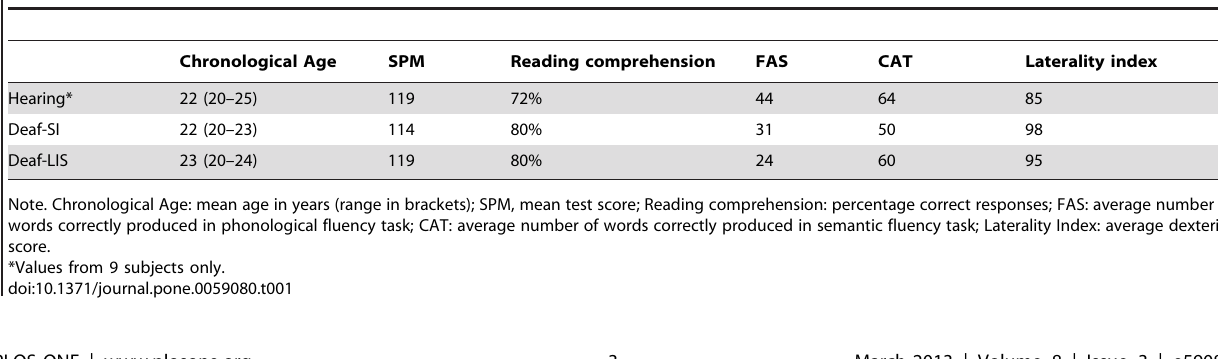
Table 1. Neuropsychological